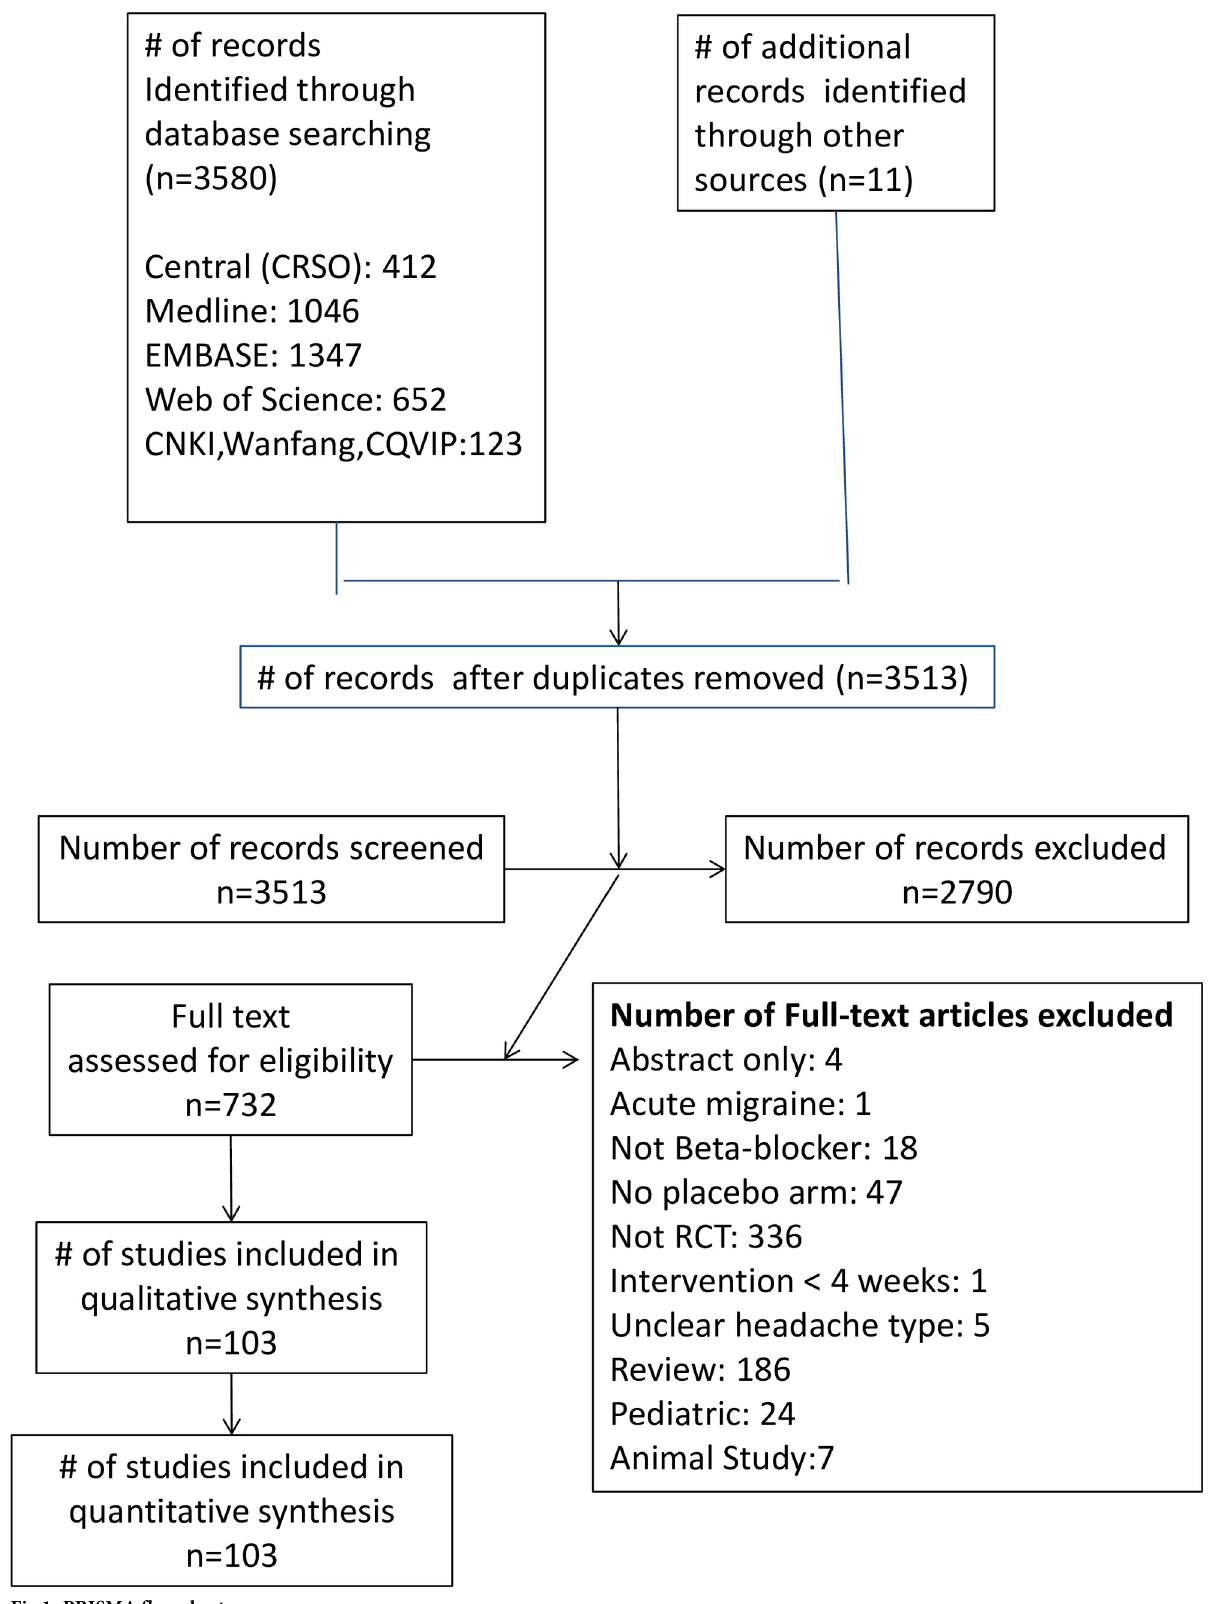
Fig 1. PRISMA flow chart. https://doi.org/10.1371/journal.pone.0212785.g001 PLOS ONE | https://doi.org/10.1371/journal.pone.0212785 March 20,